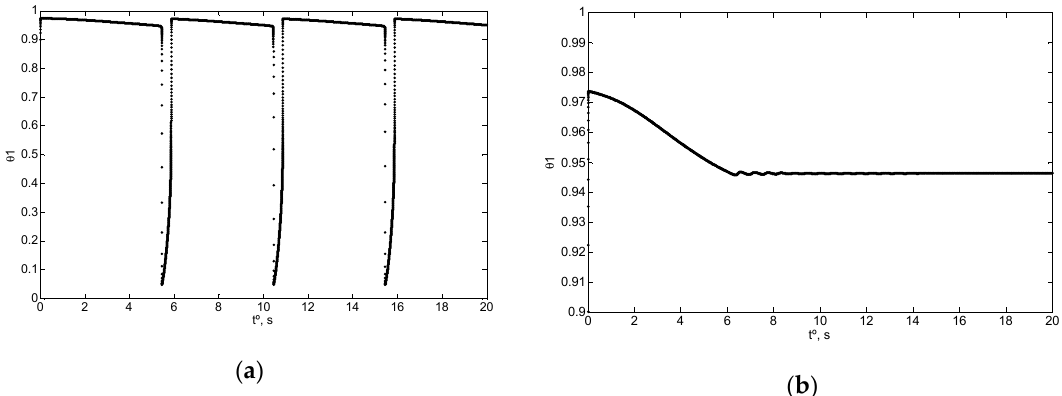
Figure 11. Superficial fractional coverage of carbon monoxide evolution at time step = 2·10 − 4 s and P 1 : ( a ) 186.651 Pa and ( b ) 187.115 Pa.